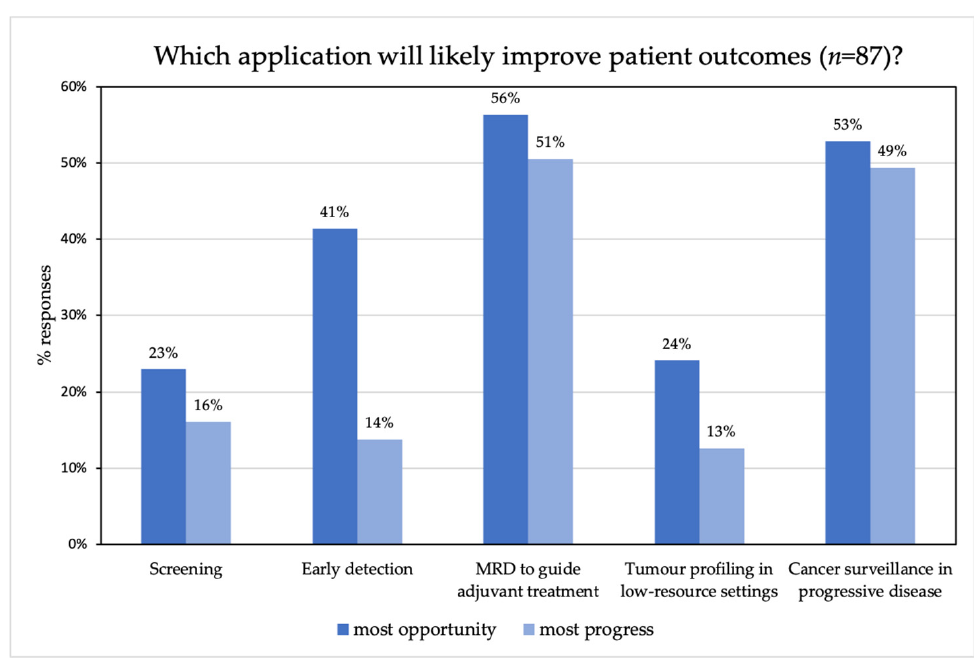
Figure 2. Pre-workshop question asking which application will likely have the most impact and for which application the most scientific progress has been made.